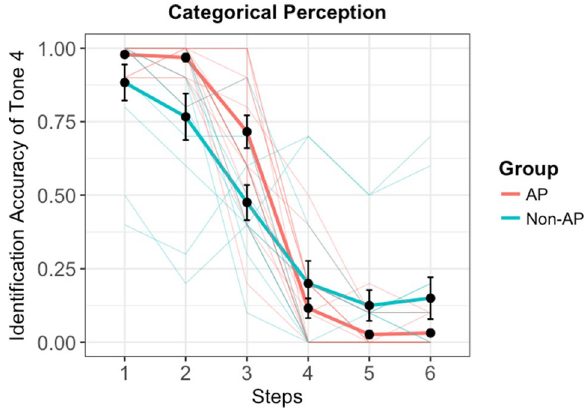
Figure 3. Comparison of AP and Non-AP groups on the identification accuracy of steps as Tone 4. Light colored lines depict individual subject curves. Error bars = ± 1